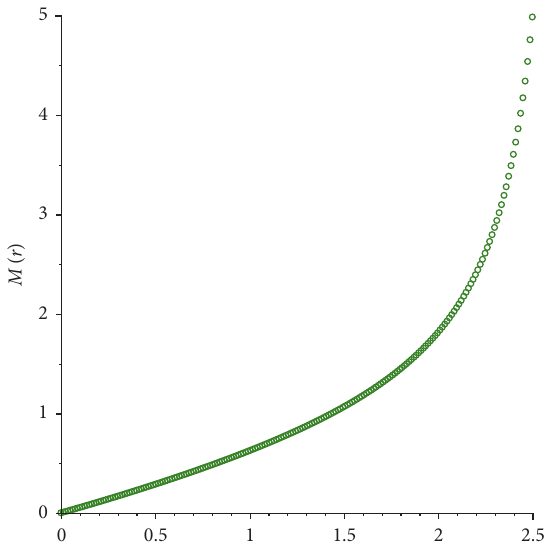
Figure 6: Evolution of the mass function with respect to the radial coordinate.